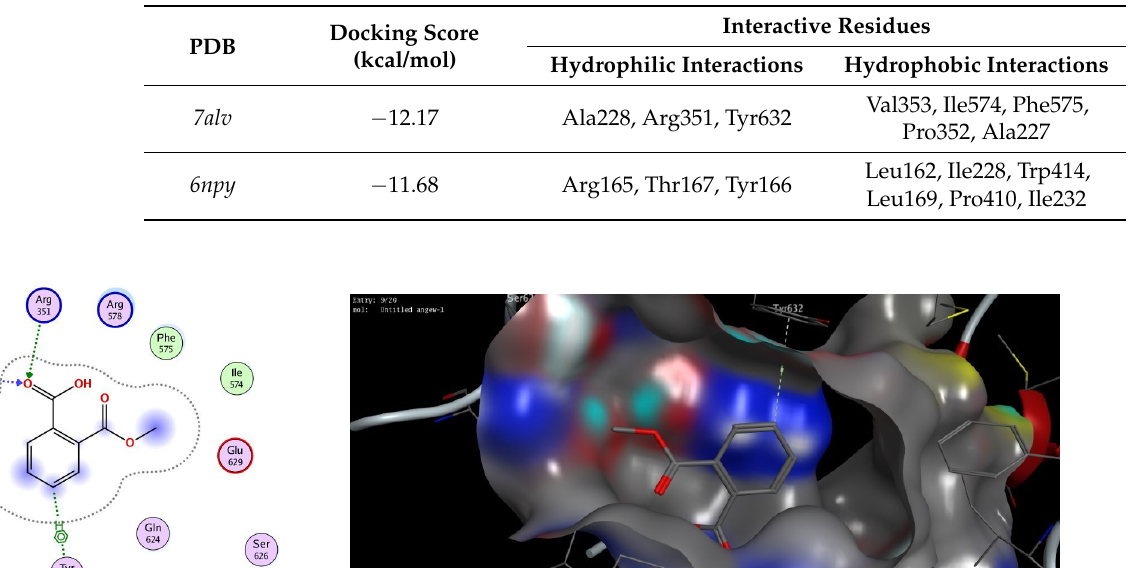
Table 4. Scores (kcal/mol) and interactions of the molecular modelling process of ASA and ATOR drugs in the NLRP3 binding sites.